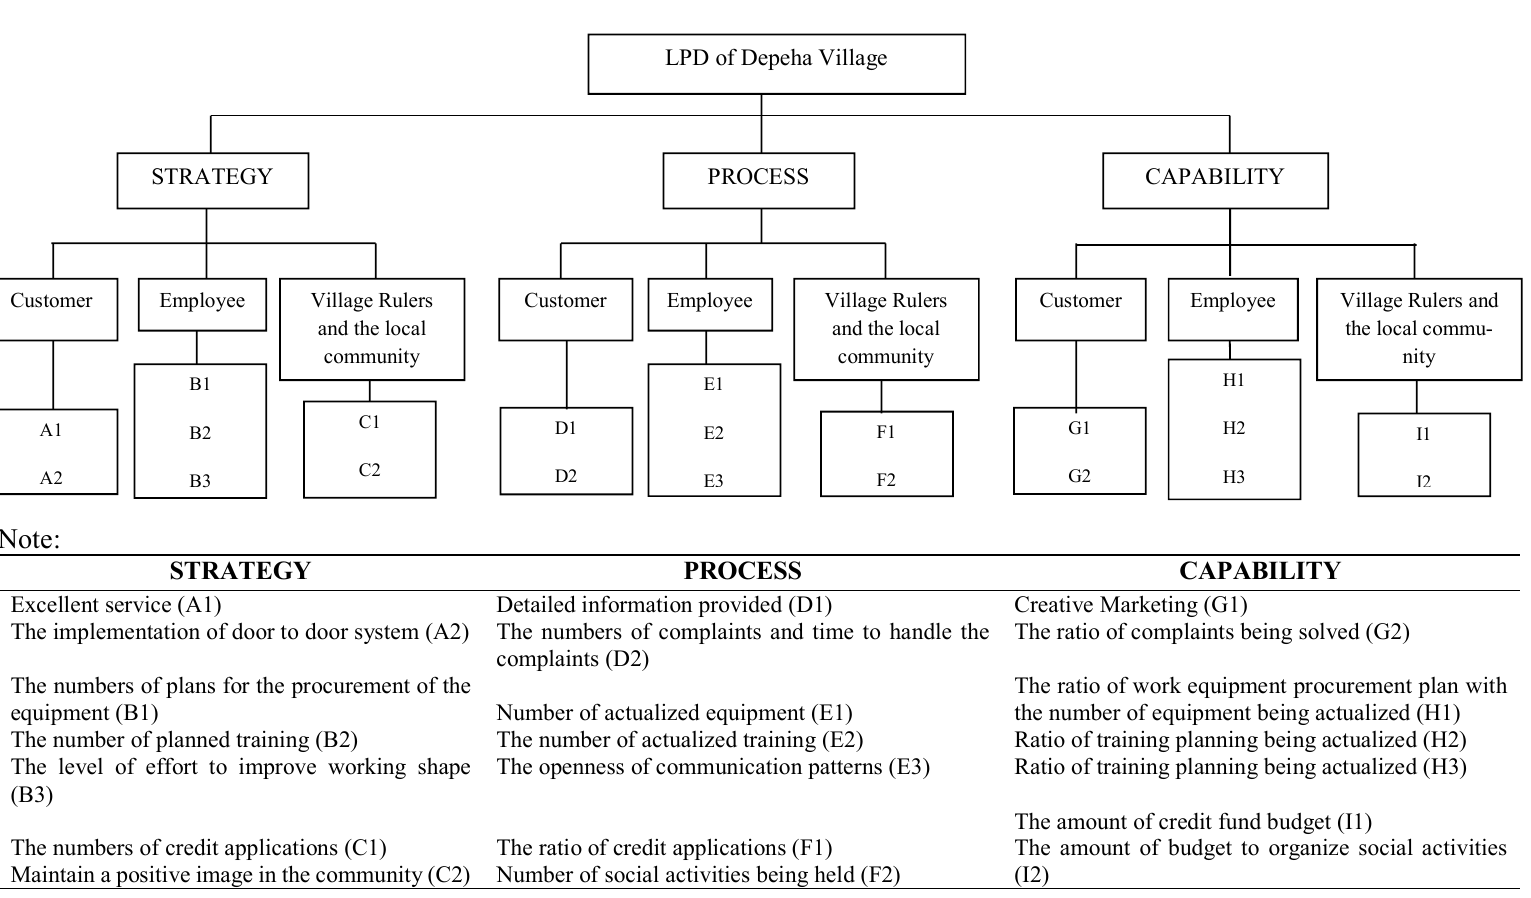
Fig. 2. Key Performance Indicator (KPI) Hierarchy Structure of LPD in Depeha